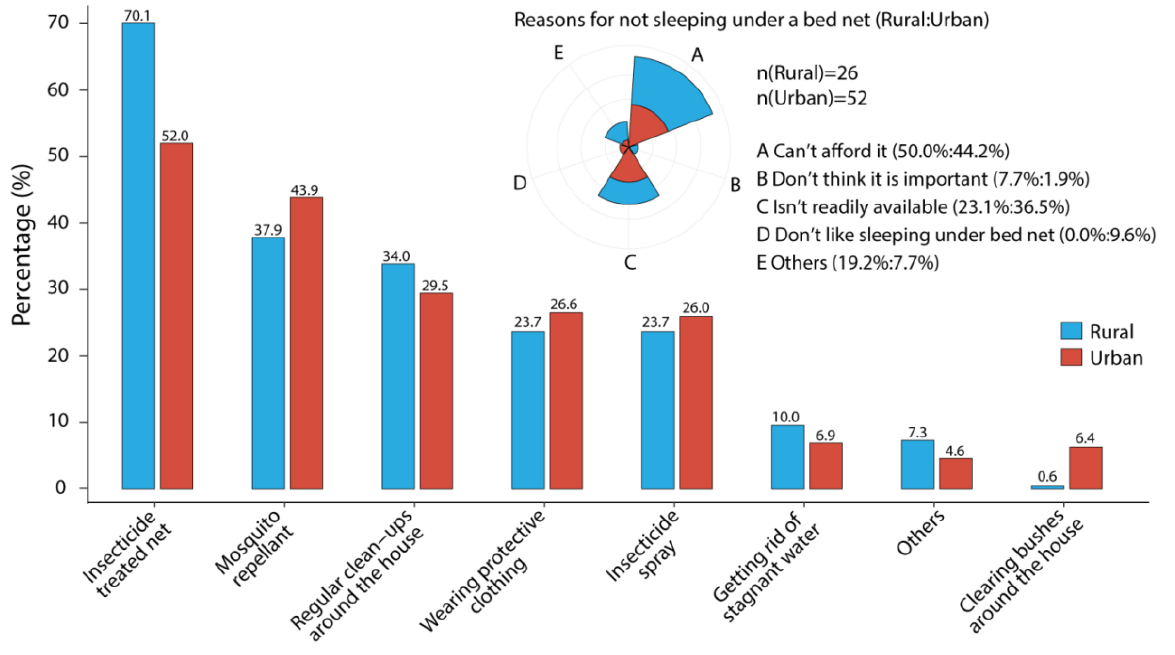
Figure 4. Protective measures against mosquito bites and the reasons for not sleeping under a bed net. The upper right diagram shows the reasons why some caregivers did not use insecticides treated nets (ITNs) in both rural and urban districts, and the proportion of the reason is shown behind the legend as Rural: Urban (%). The bar plot shows the protective measures against mosquito bites employed by caregivers of children under-5 in rural and urban districts. Blue and red represent the rural and the urban, respectively.